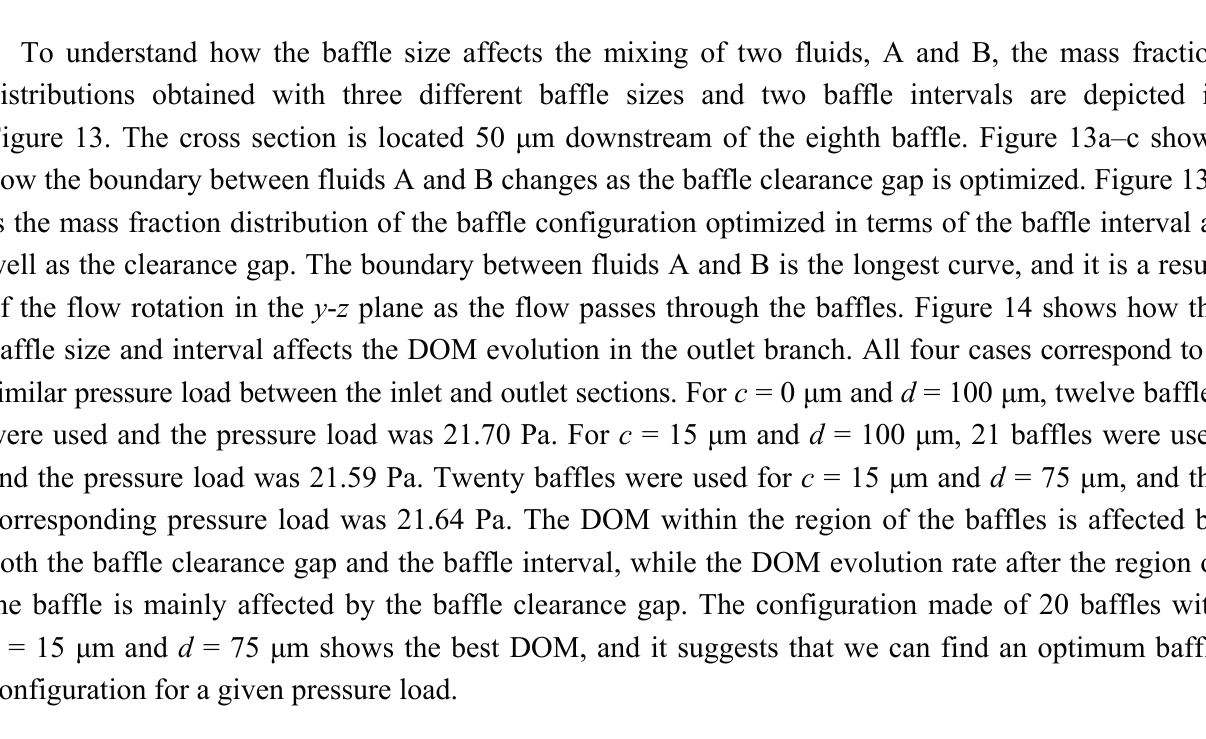
Figure 12. Effects of the baffle interval on the DOM relationship with pressure